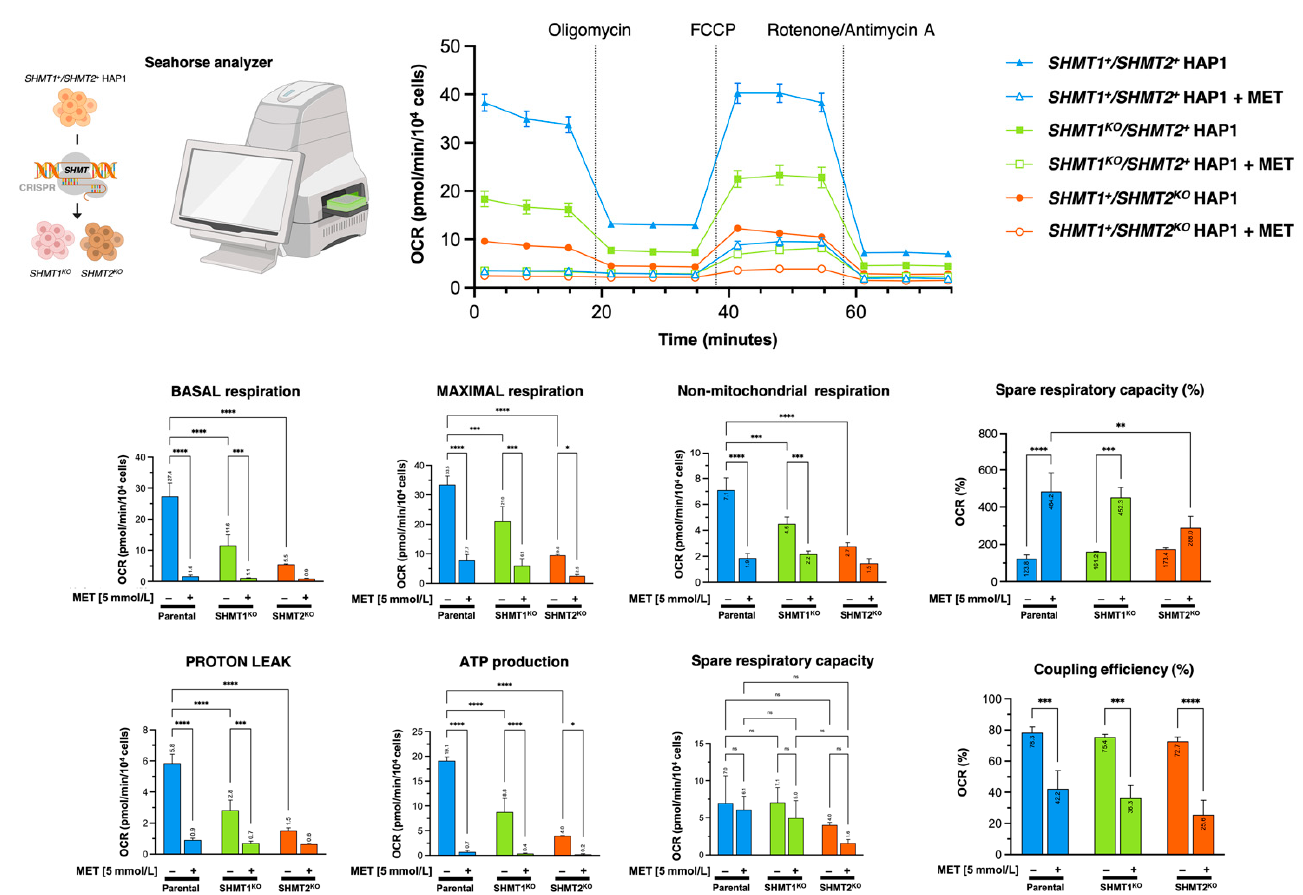
Figure 7. Depletion of SHMTs alters the mitochondrial bioenergetic profile in HAP1 cells. Top. Mitochondrial pheno- typing of HAP1 cells upon SHMT1 and SHMT2 loss using the Seahorse XFp Cell Mito Stress Test Assay. Bottom. OCR profiling. Seahorse OCR bioenergetic profiles before and after injections of oligomycin, FCCP, and antimycin A in HAP1 parental, SHMT1-KO HAP1, and SHMT2-KO HAP1 counterparts pre-incubated in the absence or presence of 5 mmol/L metformin (MET) for 24 h. **** p <0.0001; *** p < 0.0005; ** p < 0.005; * p <